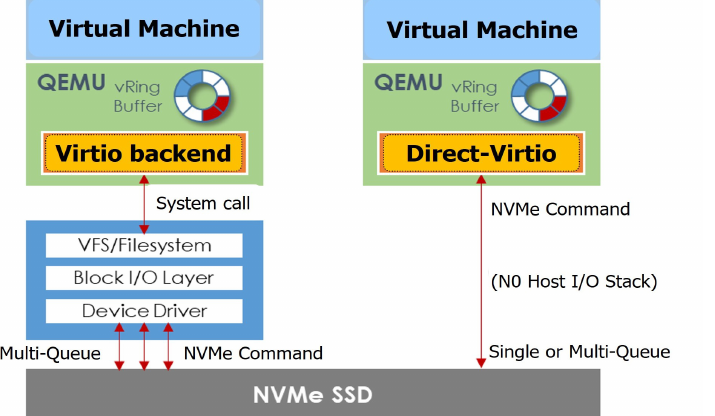
Figure 3. Direct-Virtio concept: Accessing NVMe SSDs directly allows to avoid the duplicated I/O stack